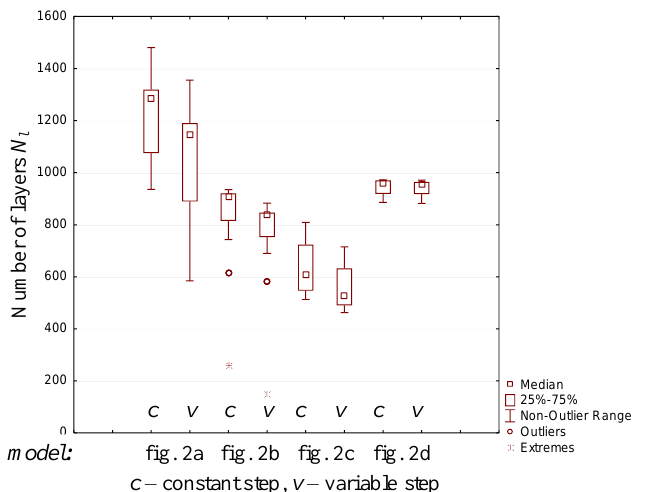
Figure 4. Statistical analysis of the number of layers for building test models for all orientations.